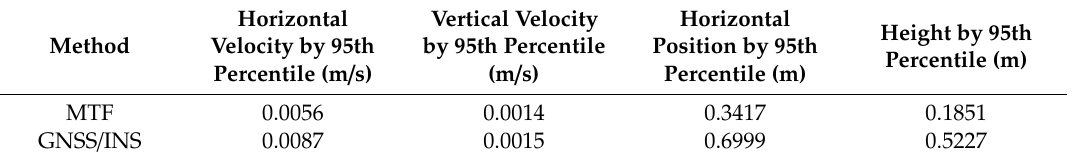
Figure 8. The position and velocity errors of the traditional GNSS / INS tightly coupled integration solution in the insu ffi cient satellite case. Table 3. Statistical analysis of the errors of the MTF method and the traditional GNSS / INS tightly coupled integration in the insu ffi cient satellites context in the simulation